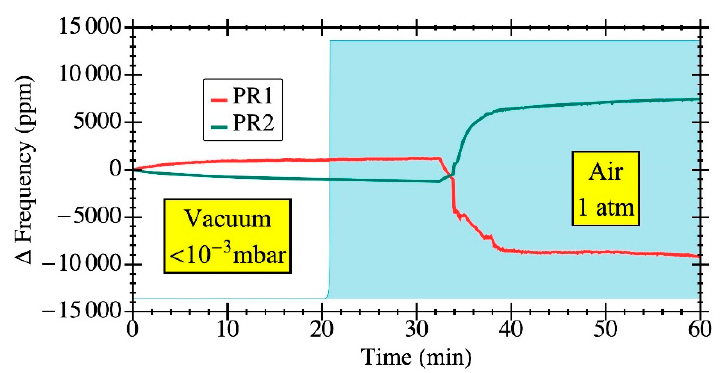
Figure 8. Relative frequency change for each one of the geometries due to variation in the operating pressure down to 10 − 3 mbar. The open-loop response in vacuum and air was also measured for an input power of − 30 dBm so as to obtain the value of Q by curve fitting. PR1 showed a Q of 190 in air and 910 in vacuum, while PR2 reached a Q of 170 in air and 750 in vacuum.